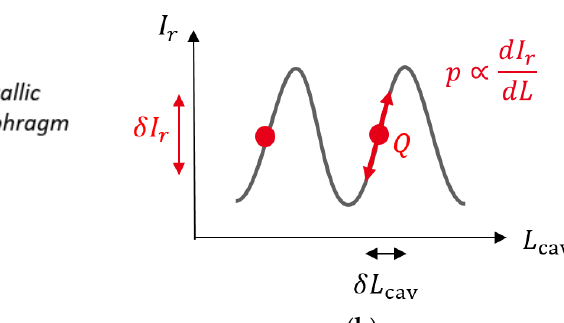
Figure 2. ( a ) Diagram of the fiber-optic Fabry–Perot based transducer; ( b ) interferometric pattern of the reflected optical signal with quadrature point Q.